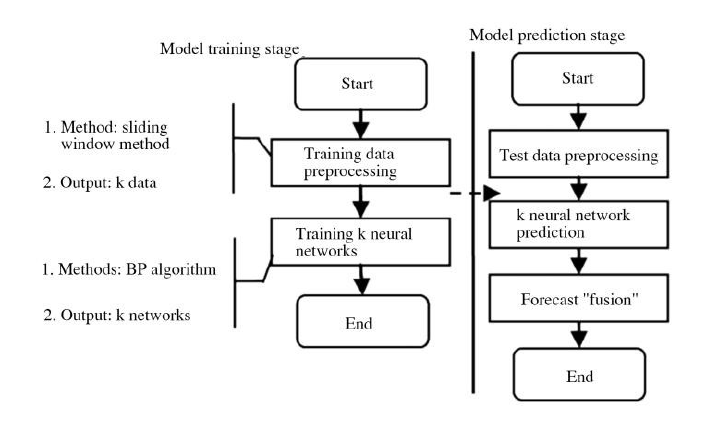
Fig. 2 Stock price forecasting